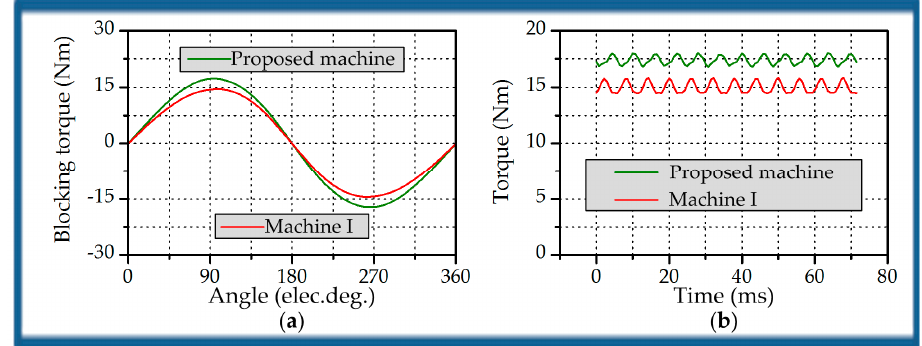
Figure 18. Performance comparison: ( a ) Blocking torque with I = 3 A; ( b ) Maximum torque with I = 3 A. Table 6. Torque ripple ratio and PF comparison.